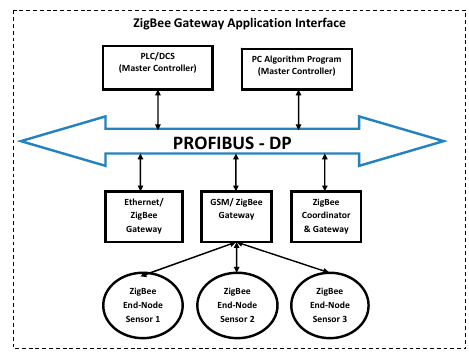
Figure 1. ZigBee gateway application